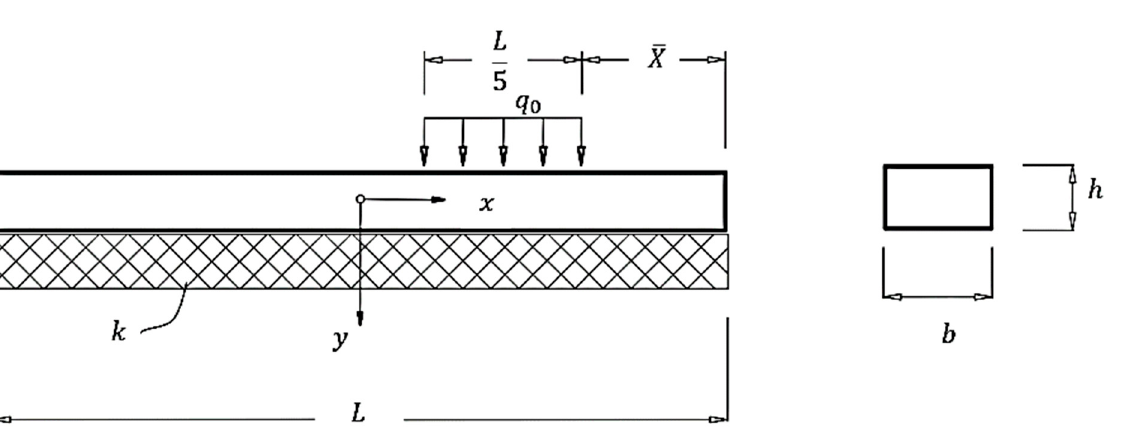
Figure 6. Free–free beam on tensionless foundation subjected to patched load.